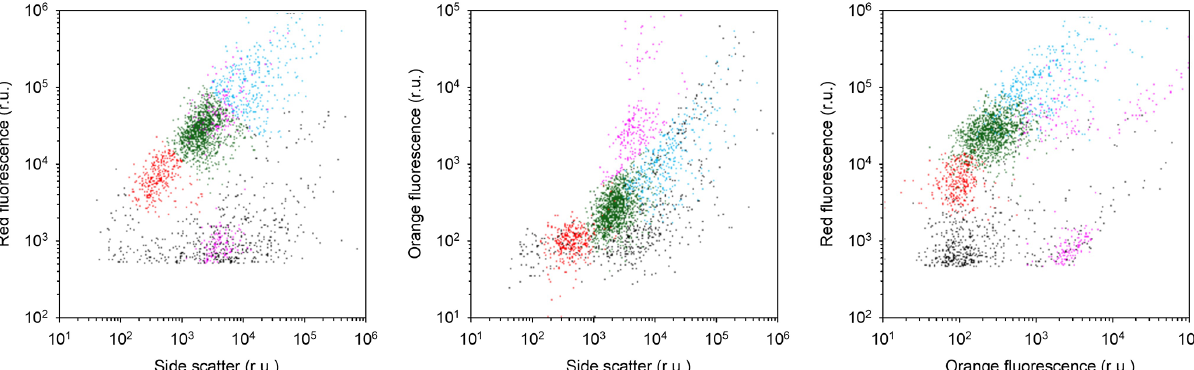
Figure A5. Scatter plots indicating the position of the different phytoplankton populations in the cytograms. Picophytoplankton, Nanophy- toplankton 1 and Nanophytoplankton 2 were discriminated based on chlorophyll red autofluorescence versus side scatter (red, green and blue dots, respectively). Possible cyanobacteria and cryptophytes were in addition recognized based on their orange autofluorescence (violet dots). The example shown is from CTD station 61 at 40m depth. Axes are in relative units (r.u.).